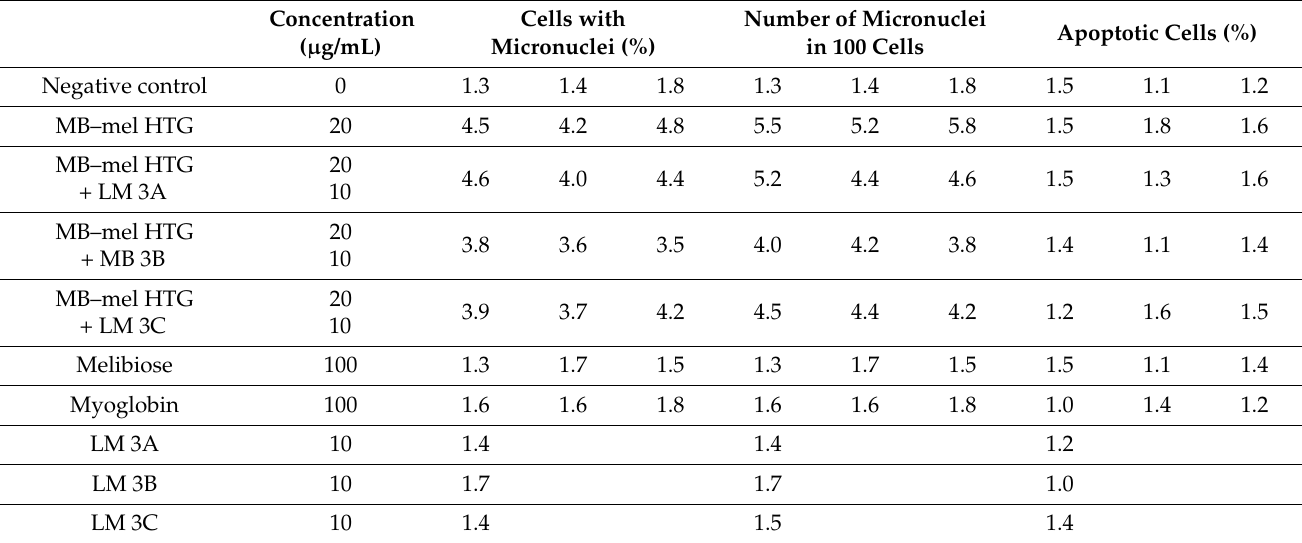
Table 10. The effect of LMW–MAGE on genotoxic activity of HTG glycation products in HCT 116 (-/-) cells.